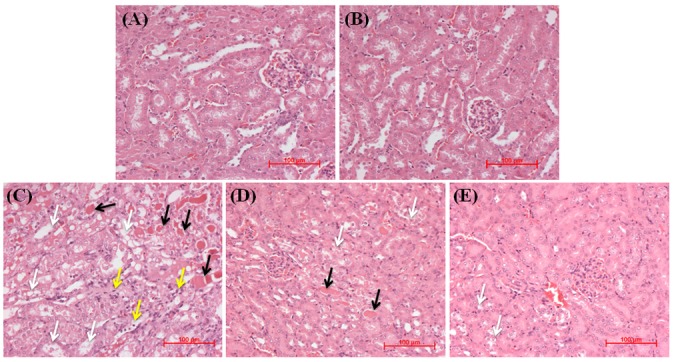
Representative photomicrographs and light microscopic examination (H and E staining) of kidney tissues treated with cisplatin and/or baicalein.Kidney tissue sections from control (A) and baicalein alone (B) treated mice showing normal kidney architecture. Kidney tissue sections from mice treated with cisplatin alone (C) showing obvious structural damage such as tubular degeneration, extensive epithelial vacuolization and necrosis (white arrow), massive infiltration of inflammatory cells (yellow arrow) and formation of hyaline casts (black arrow) in the renal tubules. Mice pretreated with baicalein at 25 mg/kg followed by cisplatin (D) showing mild to moderate degenerative changes (white arrow) with occasional casts (black arrow). Mice pretreated with baicalein at 50 mg/kg followed by cisplatin (E) showing apparently normal glomerular and tubular structure with mild tubular degenerative changes (white arrow) and without infiltration of inflammatory cells and tubular casts in the lumen.